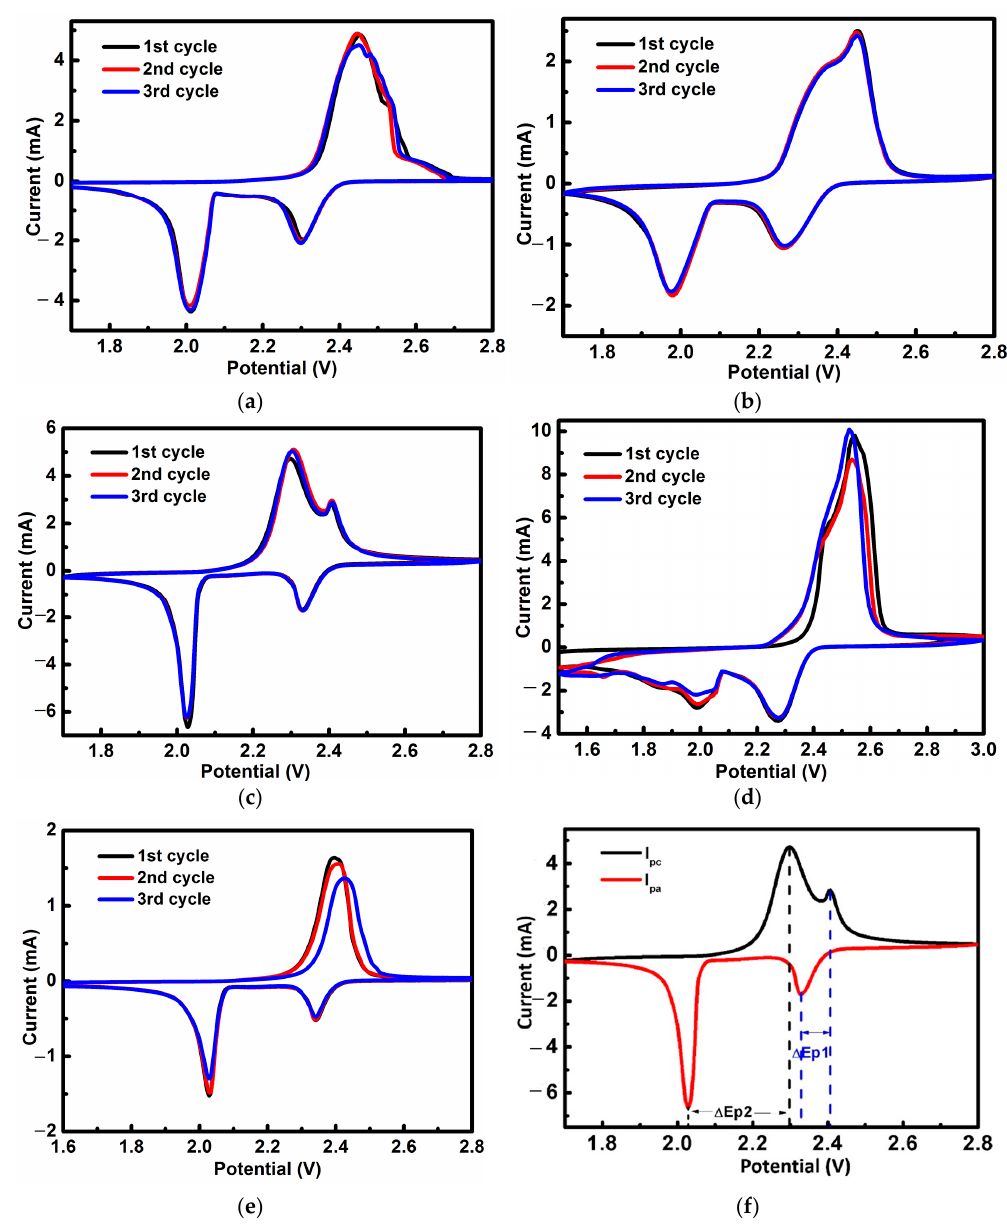
Figure 5. Cyclic voltammograms of the cell with a cathode interlayer ( a ); the cell with an anode interlayer ( b ) the cell with a double interlayer ( c ) the cell without an interlayer ( d ) and the cell with a double interlayer after 600 cycles at the rate of 1 C ( e ); the schematic of Δ Ep , Δ Ep (= Epc − Epa ) (where